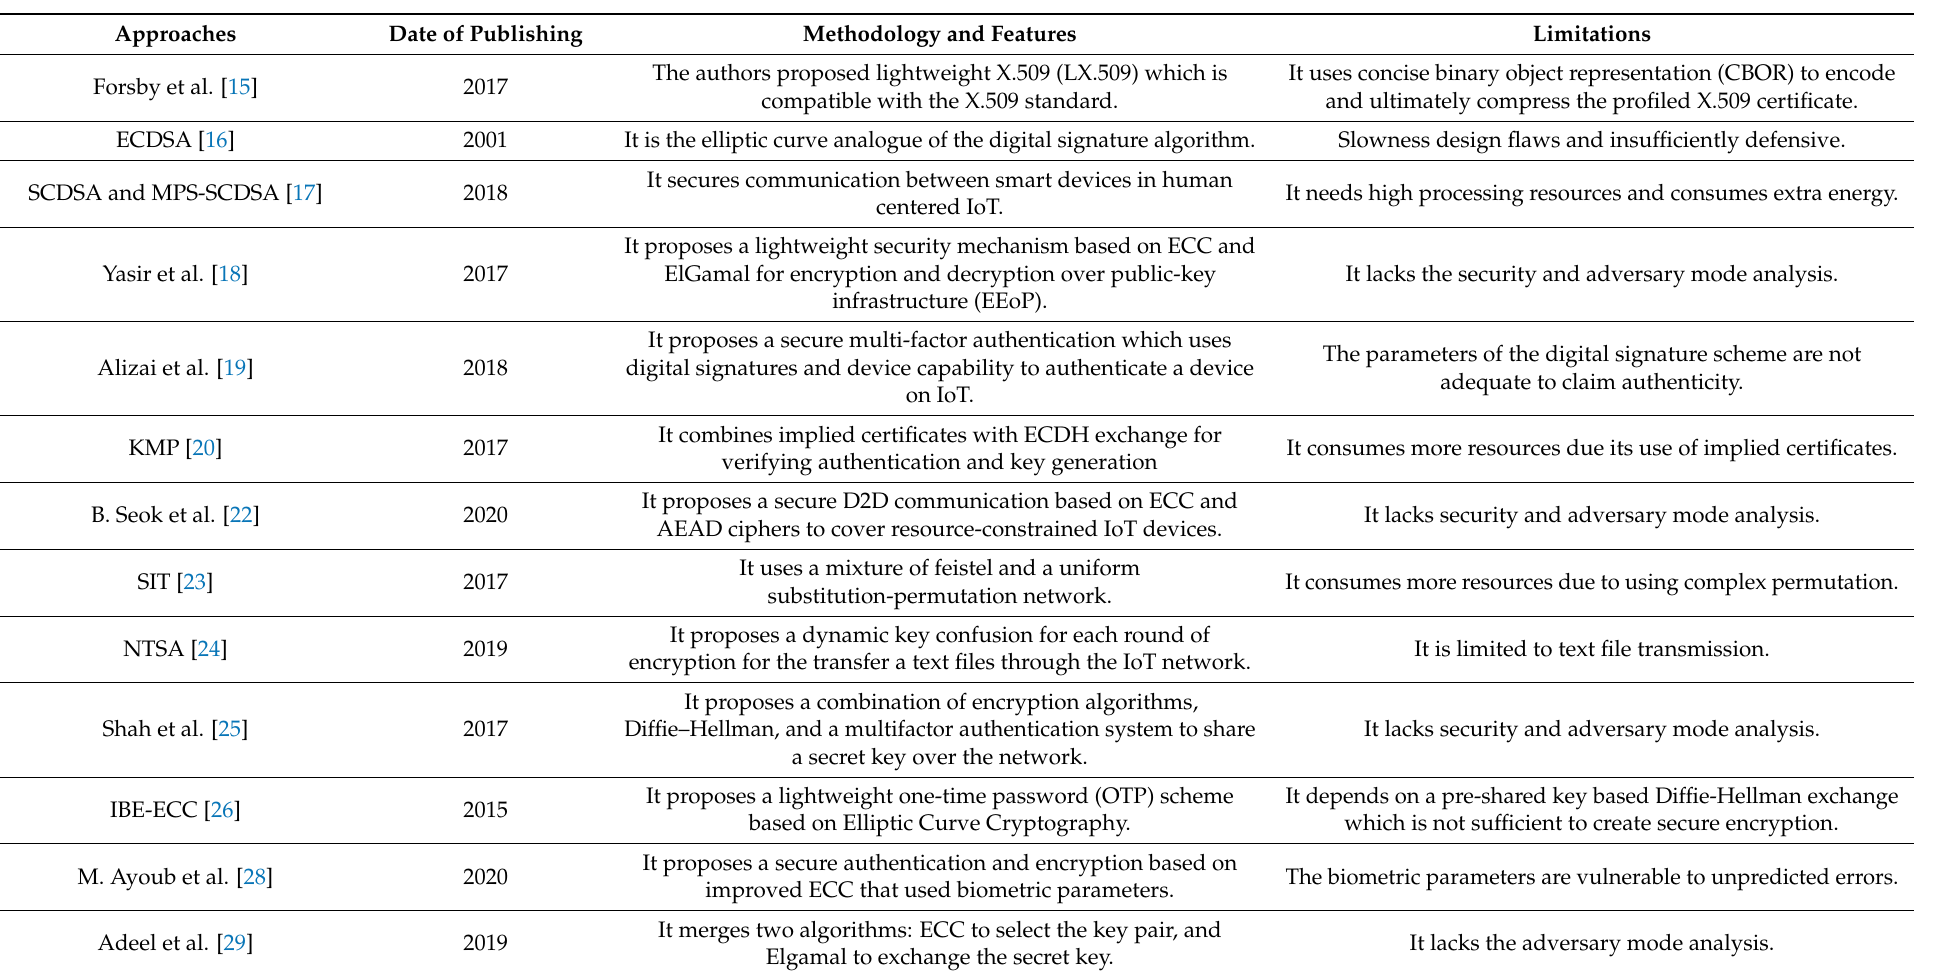
Table 1. Summary of related